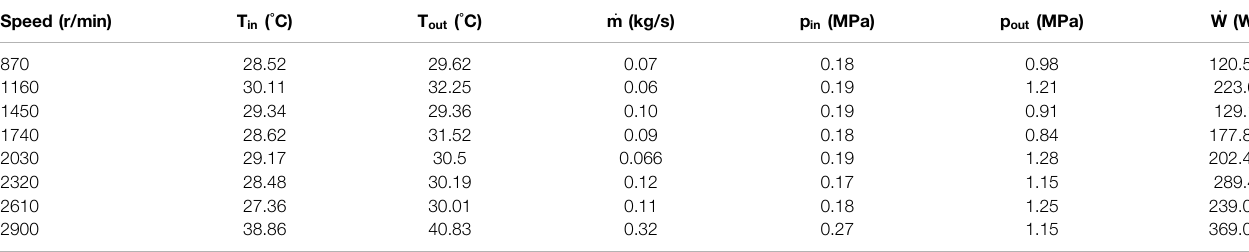
TABLE 4 | Optimal operating parameters.